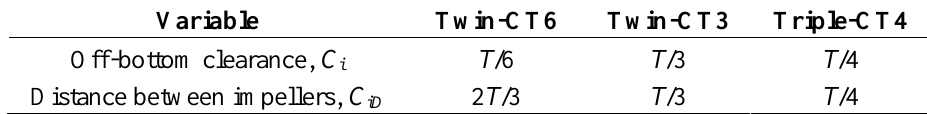
Table 4. Details of impeller configuration in multi-impeller CIL